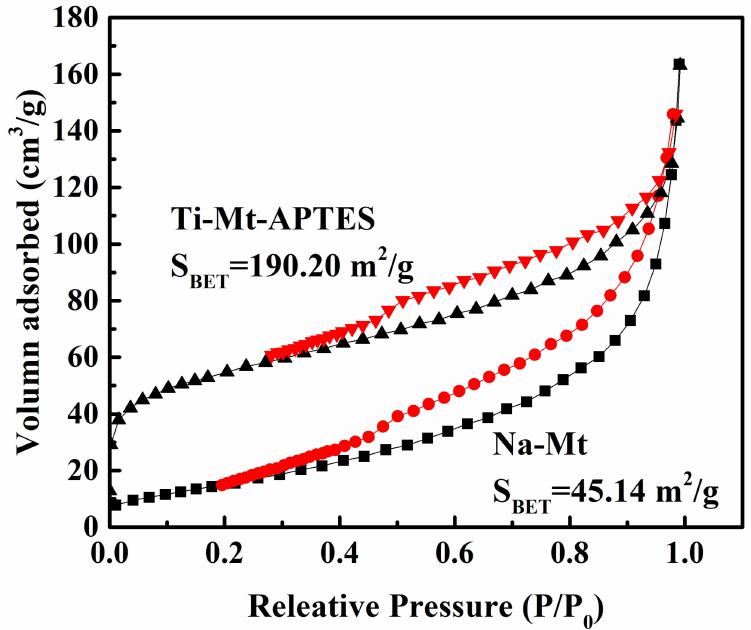
Figure 4. N 2 adsorption/desorption isotherms of Na-Mt and